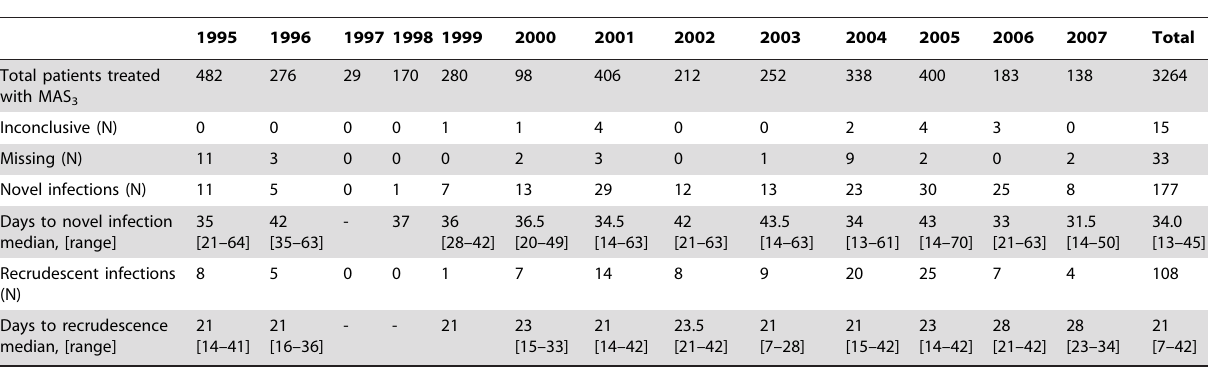
Table 5. PCR-confirmed novel and recrudescent infections and time to recrudescence.